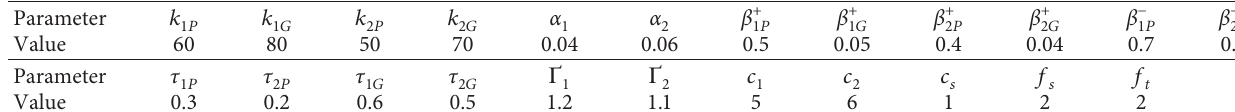
Table 5: Initial parameter values.